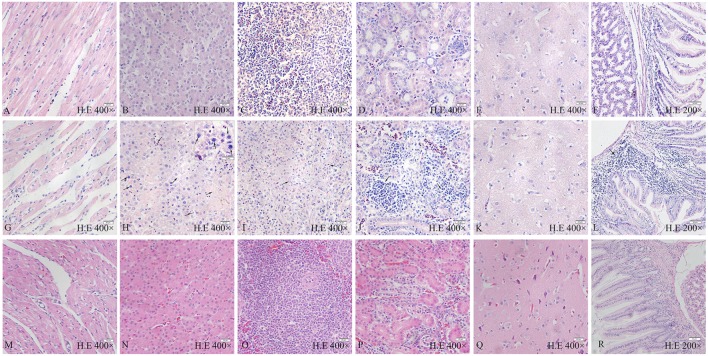
Pathological changes of FAdV-4 SD0828-infected chickens and ducks at different time points. (A–F) Heart, liver, spleen, kidney, brain, and glandular stomach, respectively, of chicken are from the control group. (G–L) Heart, liver, spleen, kidney, brain, and glandular stomach, respectively, are from the infected chicken. (M–R) Heart, liver, spleen, kidney, brain, and glandular stomach, respectively, are from the infected duck. (G) No obvious histologic lesions in the heart. (H) Large number of basophilic inclusion bodies and the vacuoles and hepatocyte necrosis (karyon pyknosis, karyorrhexis, and karyolysis) in the liver. (I) Massive loss of lymphocytes and obvious lymphocytic necrosis (karyon pyknosis, karyorrhexis, and karyolysis) in the spleen. (J) Severe lymphocytic infiltration in the kidney. (K) No obvious histological lesions in the brain. (L) Intense lymphocytic infiltration between the lamina propria and gland ducts in the glandular stomach. H&E stain, the original magnification of each organization is shown in the diagram, the scale bar = 50 µm in the (F,L,R) = 20 µm in the (A–E,G–K,M–Q) = 10 µm in the small box of (H).